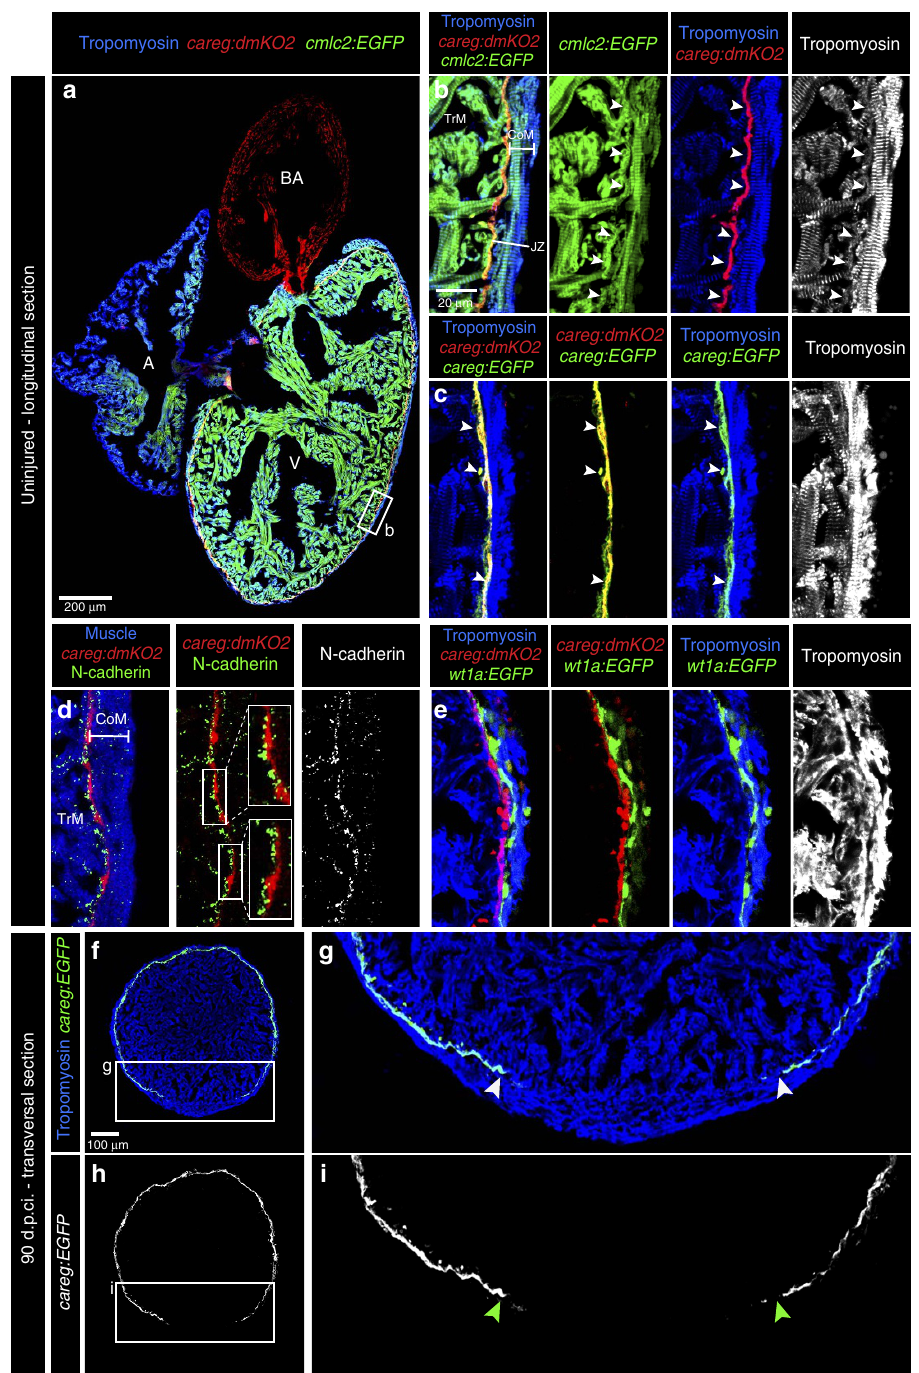
Figure 8 | Monitoring the primordial CM layer between the compact and trabecular myocardium. ( a ) Longitudinal sections of careg:dmKO2;cmlc2:EGFP transgenic adult hearts labelled with antibodies against KO2 (red) and Tropomyosin (blue, white). V, ventricle; A, atrium; BA, bulbus arteriosus. ( b ) careg:dmKO2 expression is maintained during adulthood in a single layer of thin subcortical CMs (arrowheads) in the junctional zone (JZ) between the compact/cortical (CoM) and the trabecular myocardium (TrM). N ¼ 4. ( c ) A higher magnification of the adult ventricle wall of double transgenic fish careg:dmKO2; careg:EGFP displays an overlapping expression of both markers in subcortical myocytes (arrowheads). N ¼ 4. ( d ) A magnified adult ventricle wall of careg:dmKO2 transgenic fish displays an abundant expression of N-cadherin (green, white) on the surface of the junctional CMs on the side facing the trabecular myocardium. N ¼ 4. ( e ) A fragment of the adult ventricle wall of careg:dmKO2;wt1a-6.8kb:GFP transgenic fish displays the separation of compact myocardium and subcortical careg:dmKO2 þ layer by wt1a-6.8kb:GFP -labelled fibroblasts of the junctional zone. N ¼ 4. ( f – i ) At 90 d.p.ci., transversal heart sections of careg:EGFP hearts display a gap in the primordial layer within the regenerated myocardium. The extent of the gap is indicated with arrowheads. N ¼